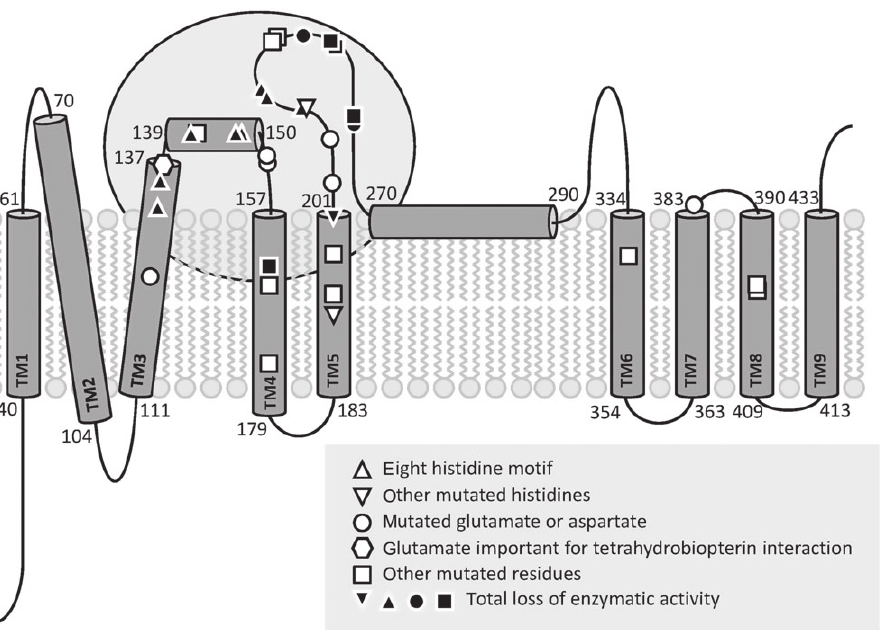
Figure 1 Schematic topography of alkylglycerol monooxygenase. Ab initio modelling and prediction tools for transmembrane (TM) segments yielded this schematic depiction of how alkylglycerol monooxy- genase might be folded into the membrane bilayer and where the active site of the enzyme is most likely to be located (highlighted in grey). Engineered mutations are shown by various symbols: triangles upward-pointing, eight histidines forming the fatty acid hydroxylases motif; triangles downward-pointing, further histidines; circles, glutamates and aspartates; squares, other mutated residues. The hexagon depicts the glutamate at position 137, which was shown to be crucial for the interaction with tetrahydrobiopterin. All mutations which led to a complete loss in enzymatic activity are shown in white frames and black filling. Reproduced, with permission, from [ 17 ]. © The Biochemical